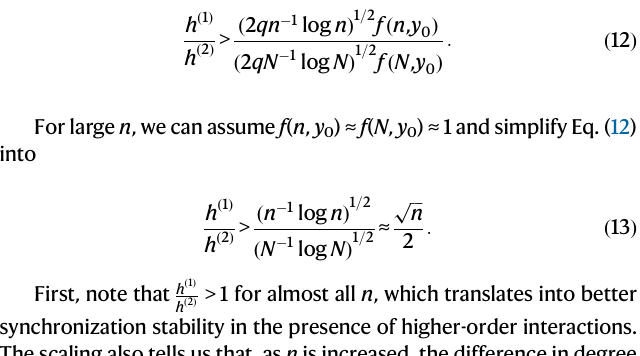
isgiven by ffiffi h ð 2 Þ